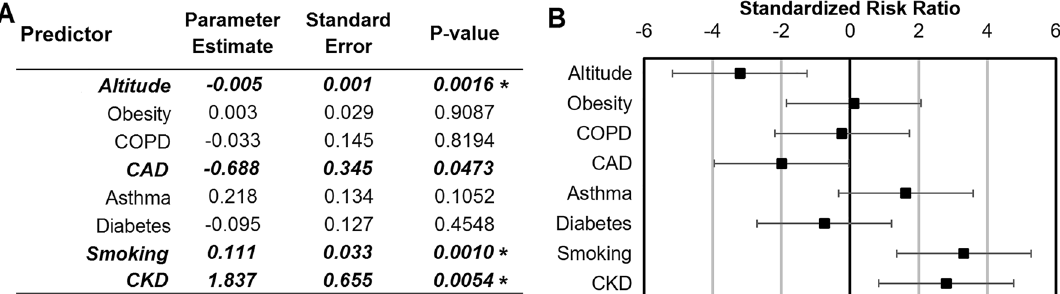
Figure 4. Elevation and comorbidities parameter risk ratio effect estimates for the mountain region adjusted by population density. ( A ) Generalized Additive Model parameter risk ratio estimates. ( B ) Standardized risk ratio estimates and confidence intervals. Values in bold are significant at P ≤ 0.05. Asterisk (*) indicates significance at a Bonferroni threshold (8